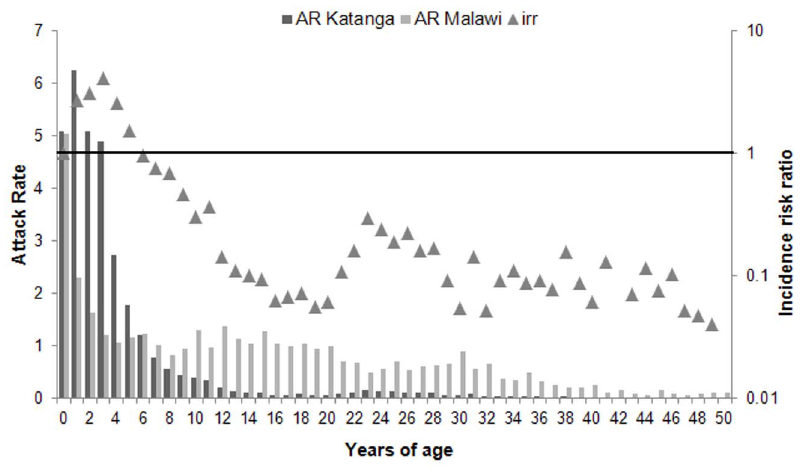
Figure 1. Age distribution of measles cases in Katanga Province (Democratic Republic of the Congo), 2010–2011, and in Malawi, 2010, as represented by attack rates, with incidence risk ratio by age. The incidence risk ratio (irr) is the age-specific AR in Katanga divided by the age-specific AR in Malawi.